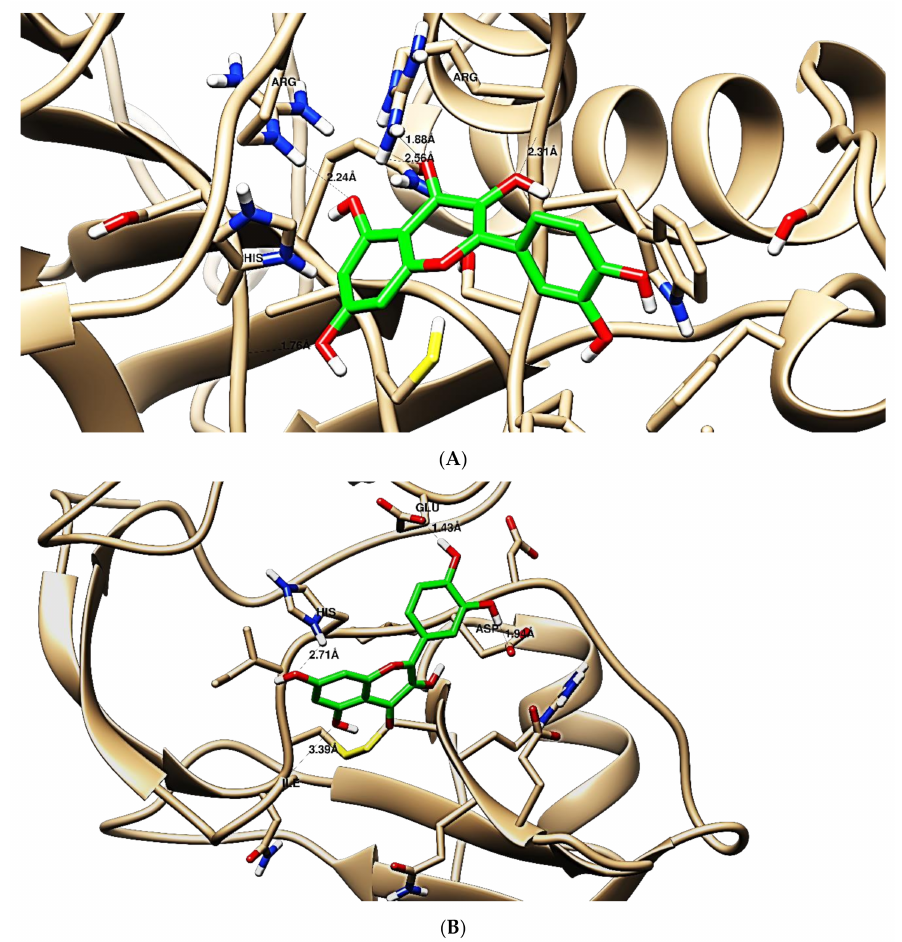
Figure 8. Binding disposition of docked compound 5 inside the active site of caspase-3 ( A ) and IFN γ ( B ) inhibition proteins with interactive key amino acids. Visualization was made using Chimera software